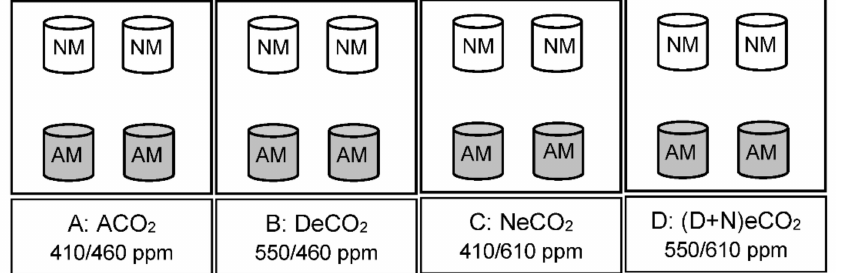
Figure 1. A schematic diagram showing the experiment designs. NM: non-AMF; AM: inoculated AMF. ( A ): ACO 2 , ambient CO 2 ; ( B ): DeCO 2 , elevated CO 2 concentrations at daytime; ( C ). NeCO 2 , elevated CO 2 concentrations at nighttime; and ( D ): (D + N)eCO 2 , elevated CO 2 concentrations at both daytime and